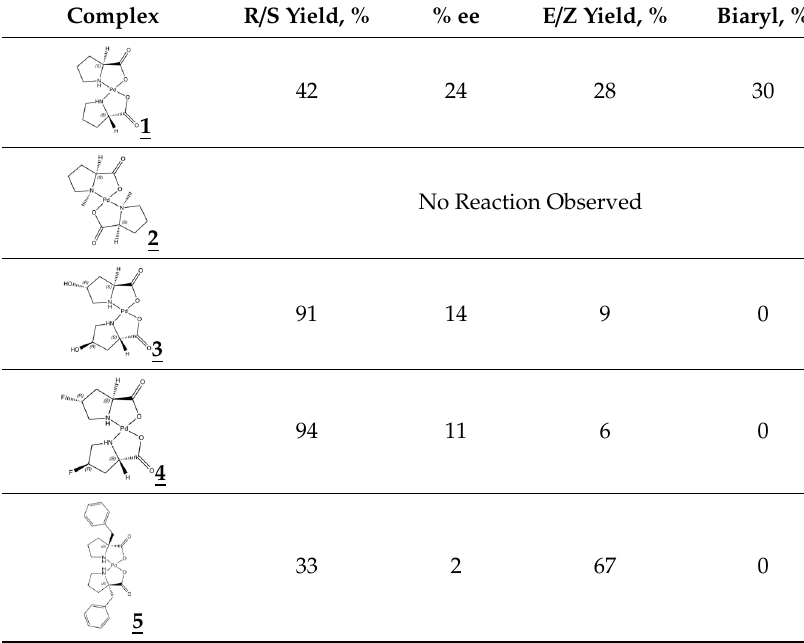
Table 1. Coupling reaction product distributions for catalysts 1 , 2 , 3 , 4 , 5 , 6 , 7 .